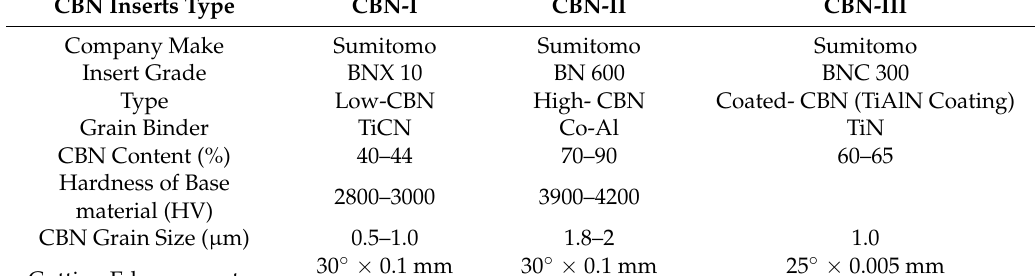
Table 2. Properties of Different CBN Inserts.